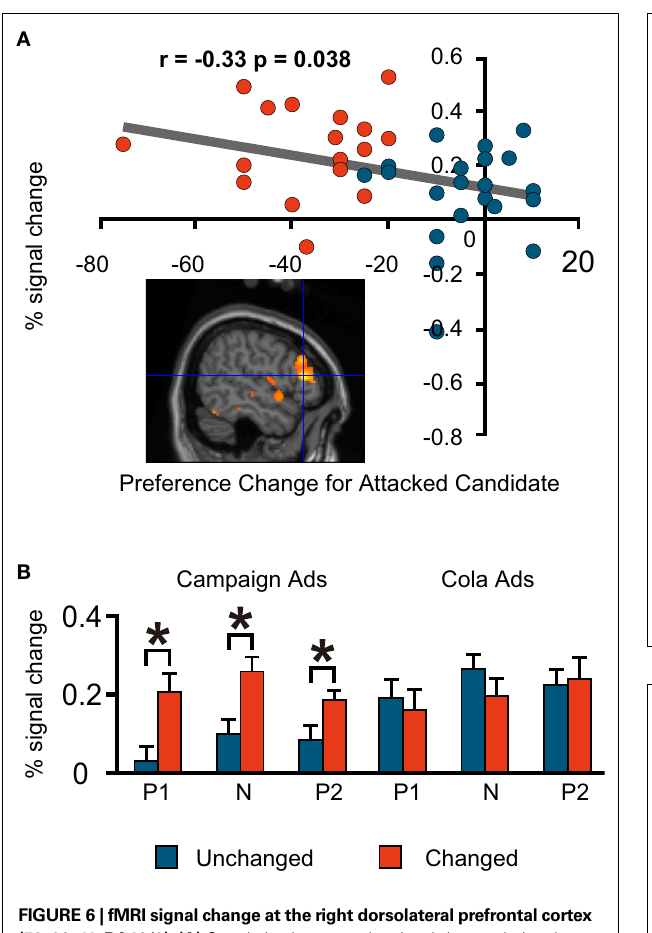
FIGURE 6 | fMRI signal change at the right dorsolateral prefrontal cortex (53, 30, 11; BA46/9). (A) Correlation between the signal change during the negative advertisements and the preference change towards a favoured candidate during the negative advertisements (=post-negative-advertisement preference for the attacked candidate − pre-negative-advertisement preference for the attacked candidate). (B) Mean comparison between the Unchanged and Changed Groups for each advertisement session.